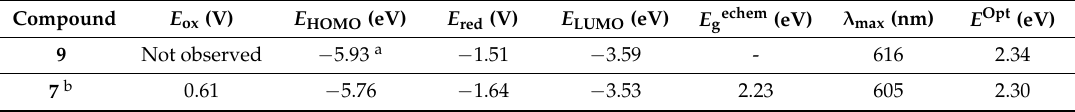
Table 1. CV and UV-vis data of 3,5-bis[5-(thiazol-2-yl)thien-2-yl]-4H-1,2,6-thiadiazin-4-one ( 9 )